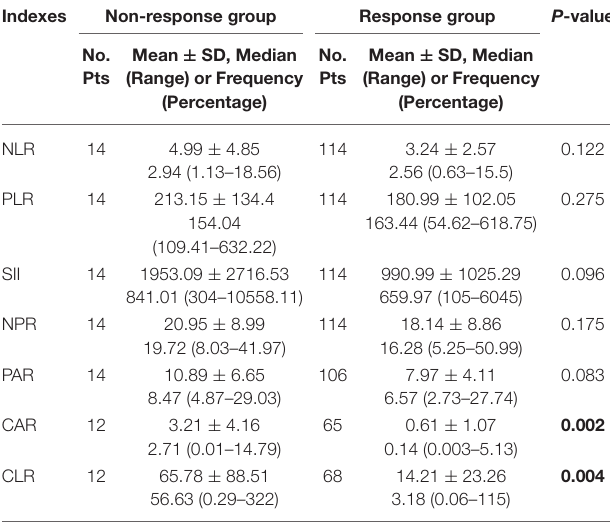
TABLE 5 | Comparison of inflammatory indexes between non-response and response to 5-ASA